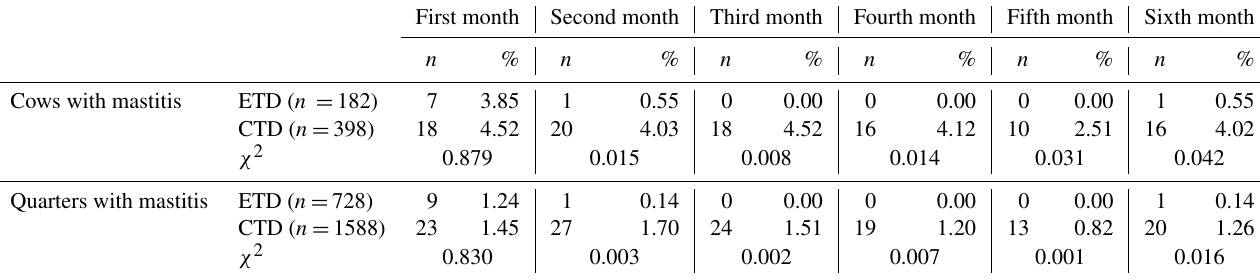
Table 1. Evaluation of the results according to the quarters and cows. First month Second month Third month